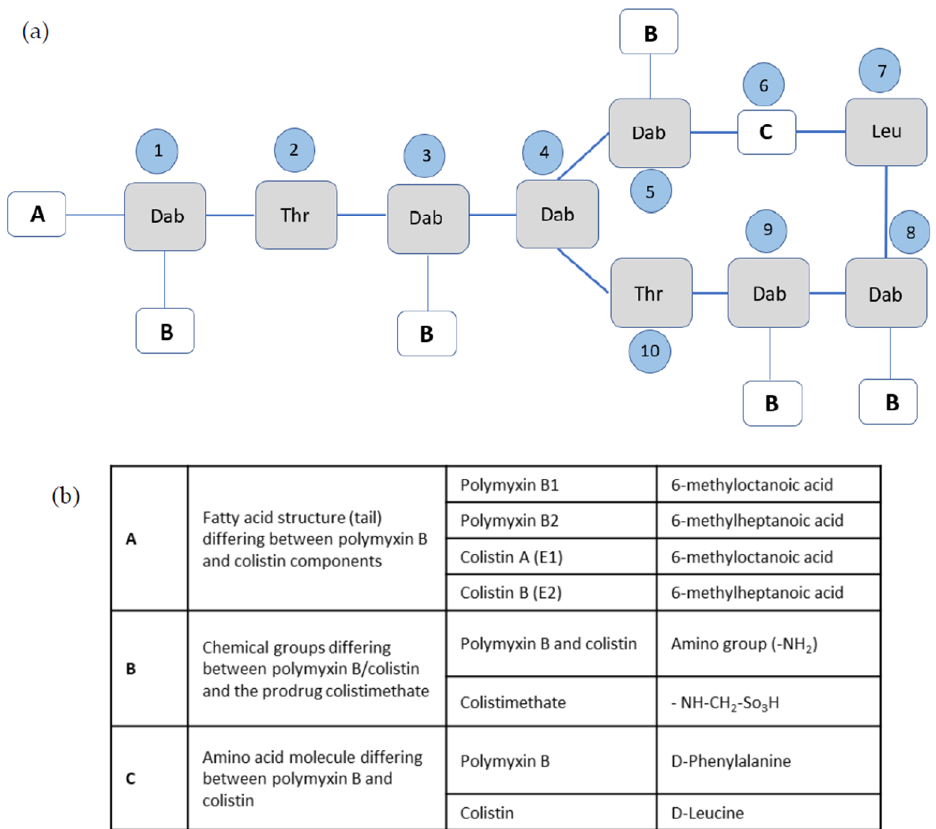
Figure 1. ( a ) Representation of the chemical structures of polymyxin B and colistin, with components B1, B2, E1, and E2, as well as colistimethate. The shaded boxes represent the fixed portions of the molecule, while the white boxes represent the structures that di ff er among polymyxin B, colistin, and / or colistimethate. The numbers in the blue circles correspond to the numbering of the amino acids from 1 to 10. The linear part of the molecule consists of a tripeptide (amino acids 1–3), while the cyclic part consists of a heptapeptide (amino acids 4–10). Dab = L- α , γ -diaminobutyric acid, Thr = Threonine; Leu = Leucine. ( b ) The groups A, B, and C in section (a) are described, and they represent the chemical moieties with variation between the polymyxins B1, B2, E1, E2 or between them and the prodrug colistimethate.